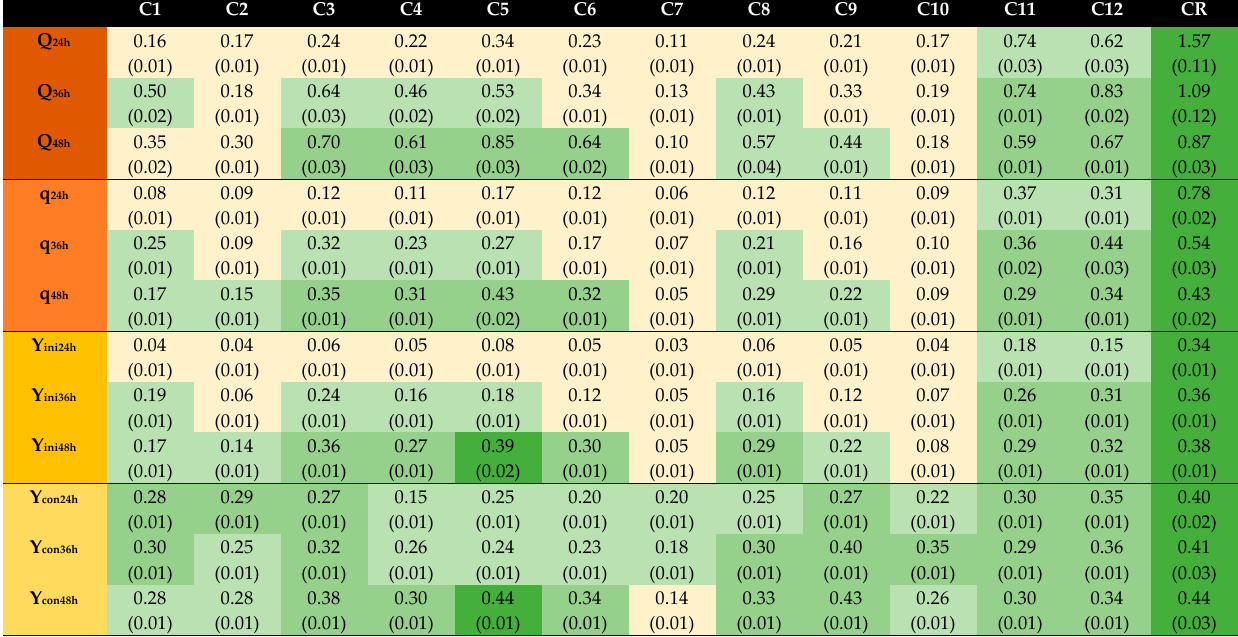
Figure 3. Fermentation results from the third experimental series (C1–CR). Codes refer to conditions detailed in Table 1. Calculations are based on the results obtained after 24 h, 36 h, and 48 h of fermentation. Standard deviations are shown in parentheses. Color scheme: